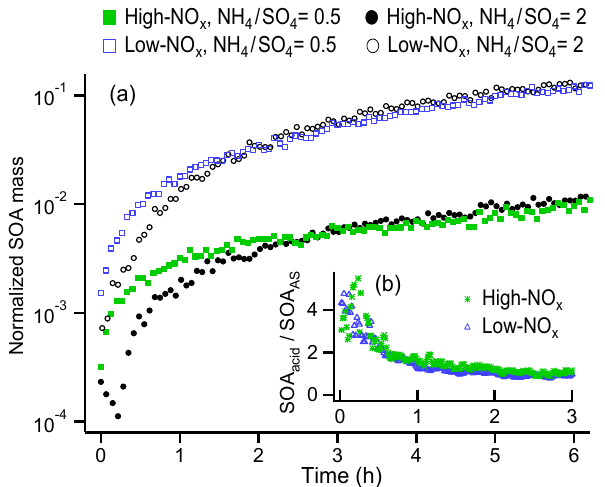
Figure 6. The mass fractions of organic fragment groups in total organic aerosols under (a) high- and (b) low-NO x conditions. The organic mass spectra were averaged for the irradiation times of 1–6 and 2–12h under high- and low-NO x conditions, respectively. The bars represent the standard deviations ( ± 1 σ ) of the mean values for individual fragment